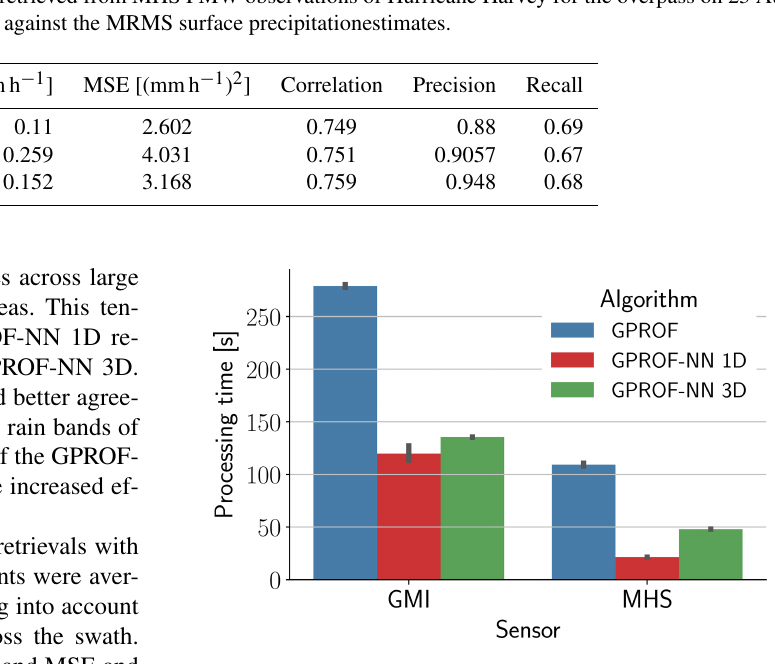
Figure 14. Single CPU core processing time for an orbit of obser- vations for the three retrieval algorithms for GMI and MHS. Error bars show the range of 1 standard deviation around the mean for five executions of each